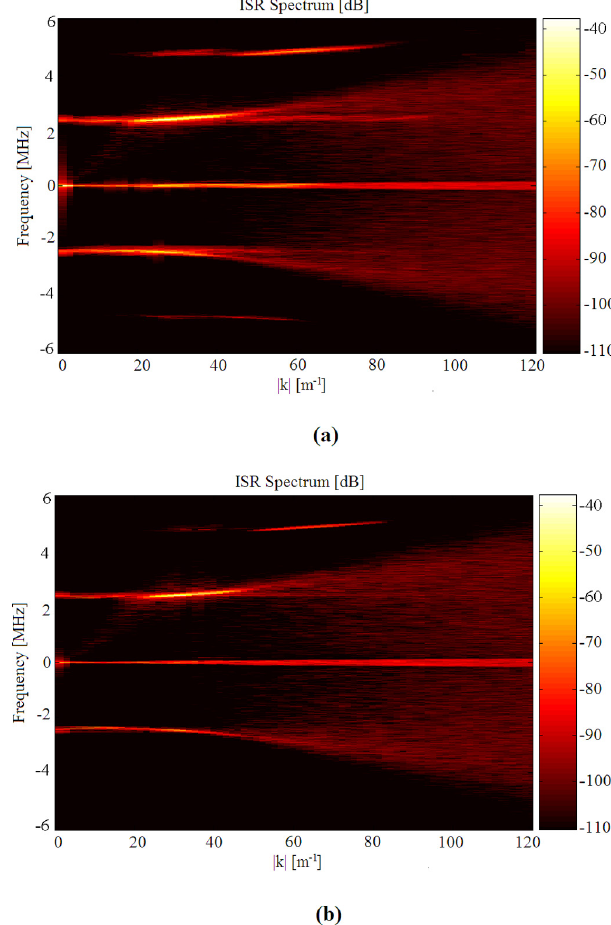
Fig. 8. Incoherent scatter spectrum for simulations with parameters presented in Sect. 3.2 for (a) v b = 6 . 75 × 10 5 ms − 1 and (b) v b = 4 . 9 × 10 5 ms − 1 . The spectrum associated with v b = 7 . 8 × 10 5 ms − 1 is shown in Fig.